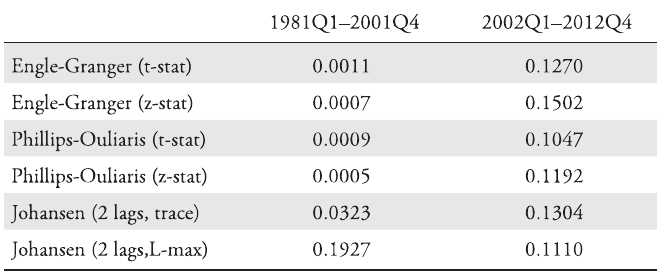
Table 3: Cointegration Tests,